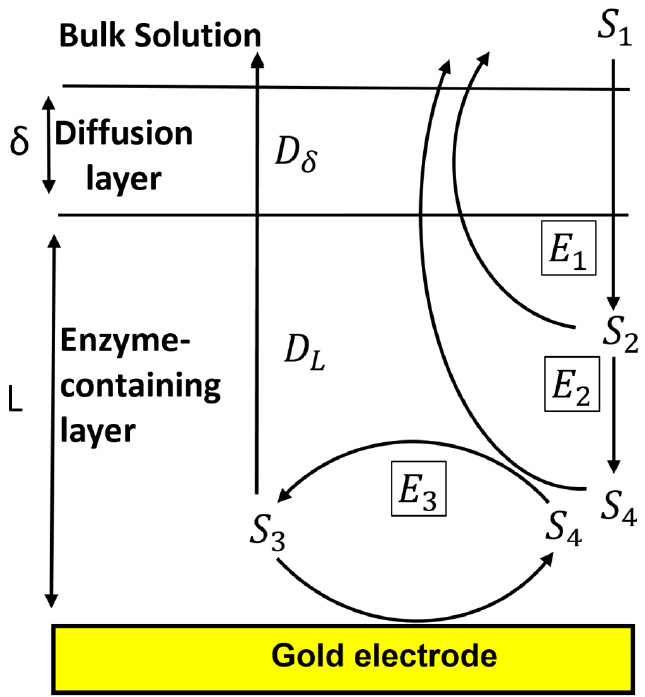
Figure 1. Schematic representation of reactions in the IBE biosensor interface. S 1 , S 2 , S 3 , and S 4 denote phenylacetate, phenol, catechol, and o-quinone, respectively. E 1 , E 2 , and E 3 denote acetylcholinesterase, tyrosinase’s phenolase activity, and tyrosinase’s catecholase activity, respectively.